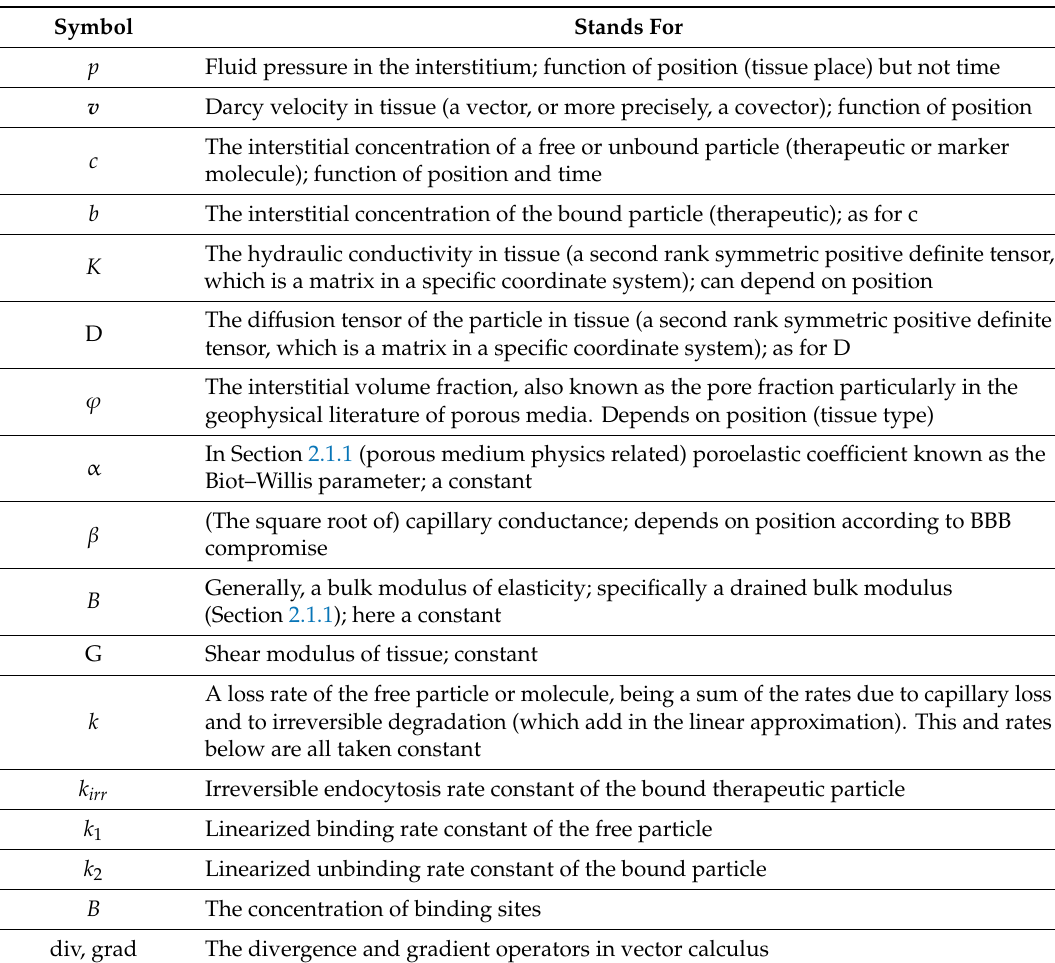
Table 1. Glossary of Selected